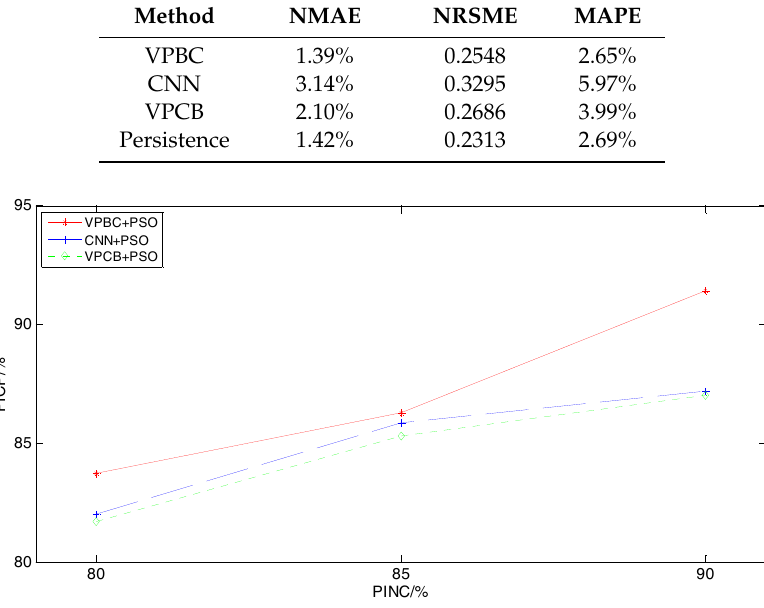
Figure 15. Comparison of the PICP indices of the different methods.